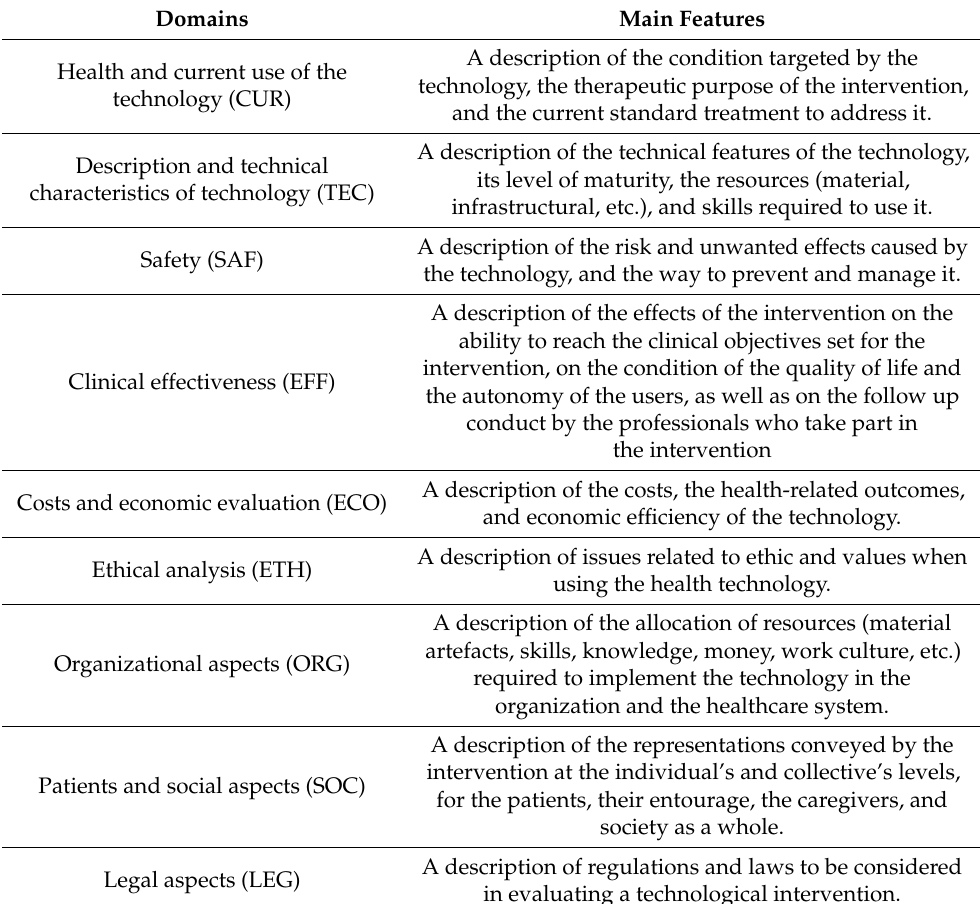
Table 1. Domains of assessment of the health technology assessment (HTA) core model version